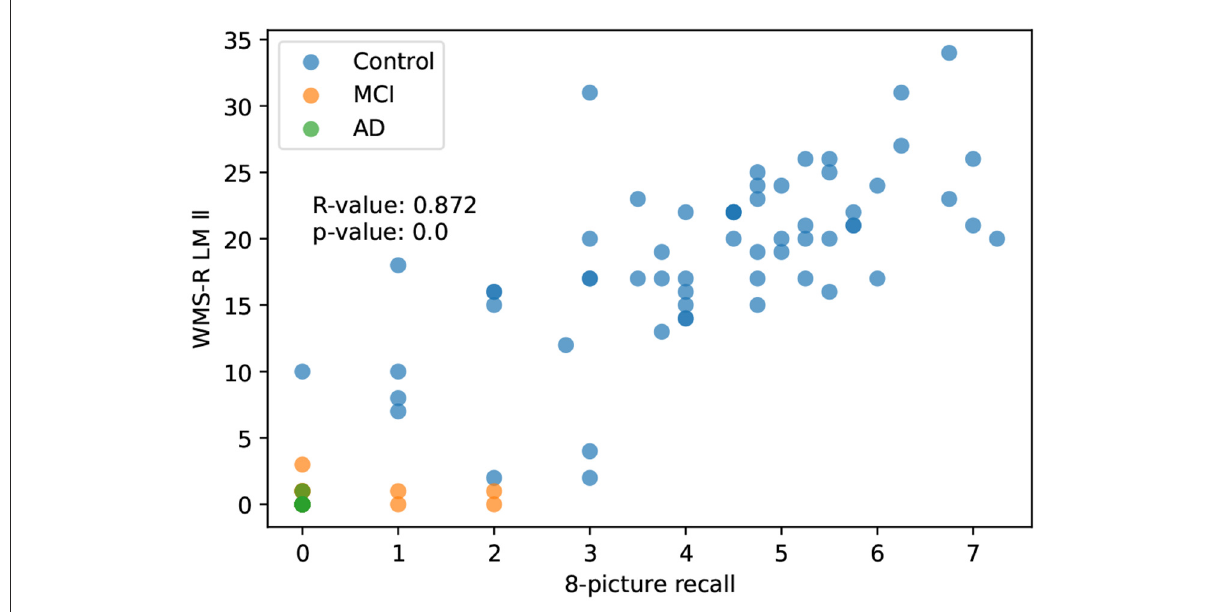
FIGURE3 The correlation between 8-picture recall and WMS-R delayed recall.